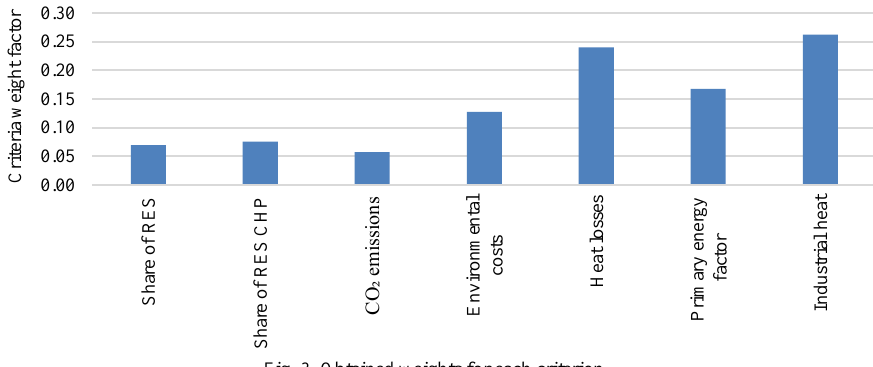
Fig. 3. Obtained weights for each